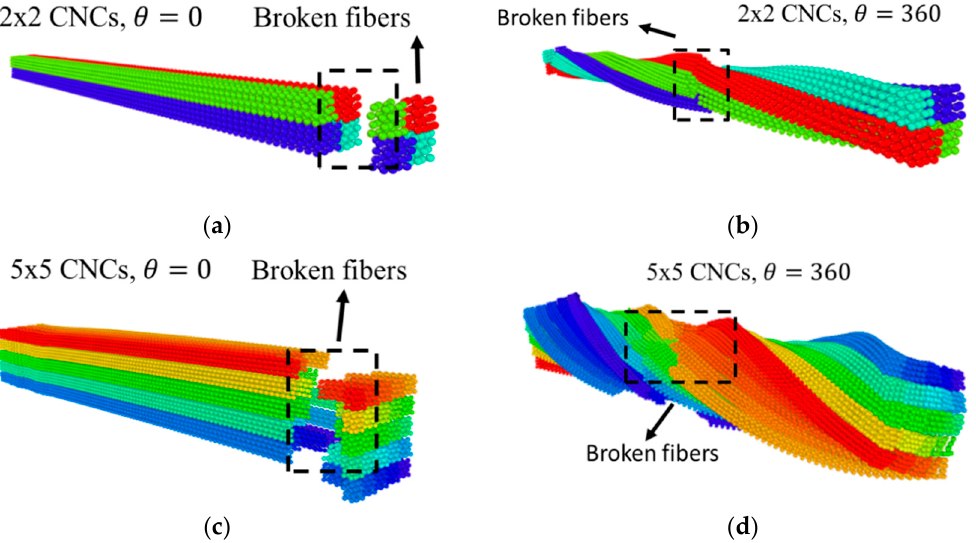
Figure 8. Failure mechanism for 2 × 2 and 5 × 5 bundles at θ = 0, θ = 360 and 𝜖 = 5.0 kcal/mol. ( a ) 2 × 2 bundle with θ = 0, ( b ) 2 × 2 bundle with θ = 360, ( c ) 5 × 5 bundle with θ = 0, and ( d ) 5 × 5 bundle with θ = 360.